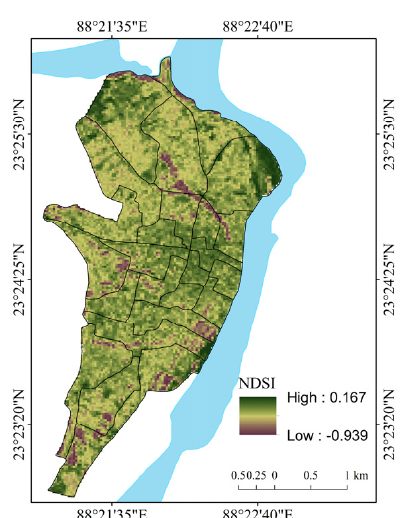
Figure 23. ND B I (2000). Figure 23. NDBI (2000).